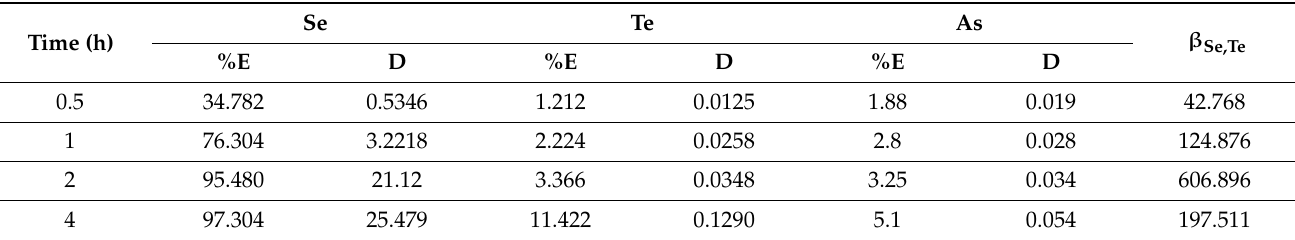
Table 8. Selenium and tellurium cementation by 20 g/L Cu